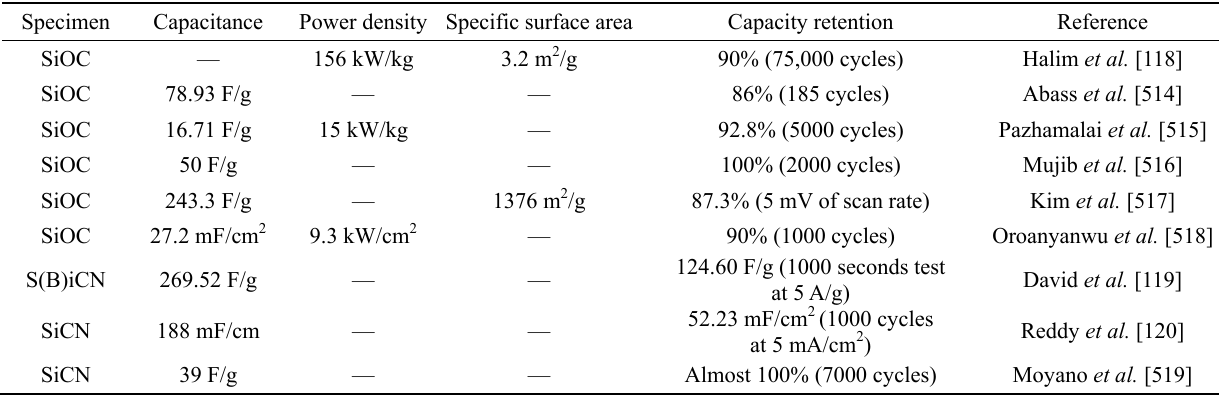
Table 4 Electrochemical performance of PDC electrodes used in